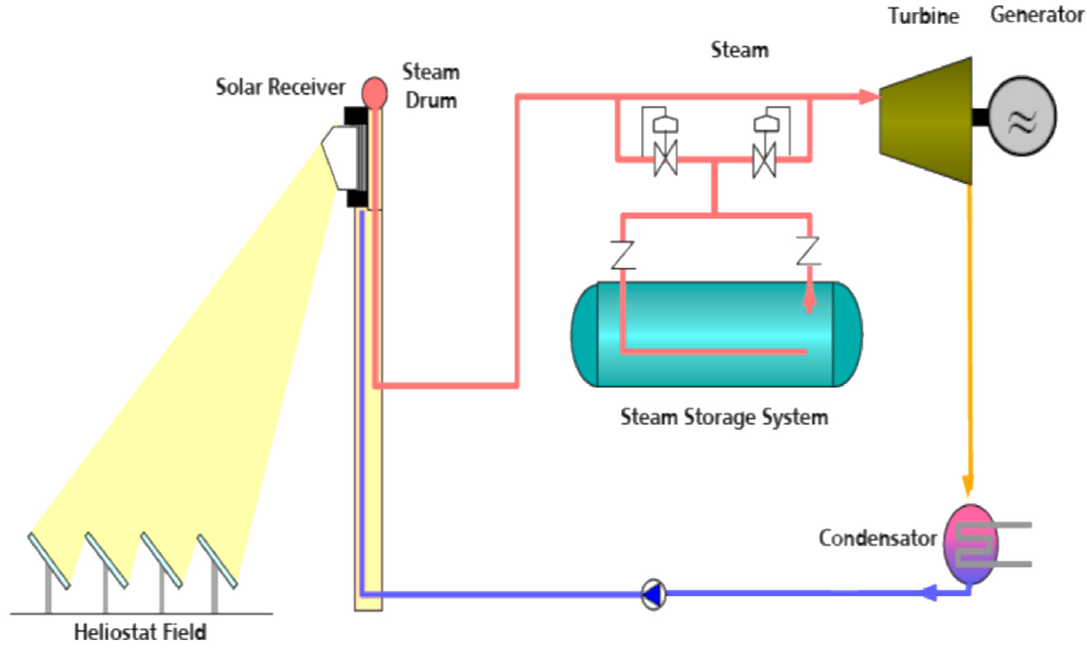
Figure 1. Schematic flow diagram of a direct steam generation tower plant (saturated steam) with steam accumulator thermal energy storage system (Source: Abengoa).